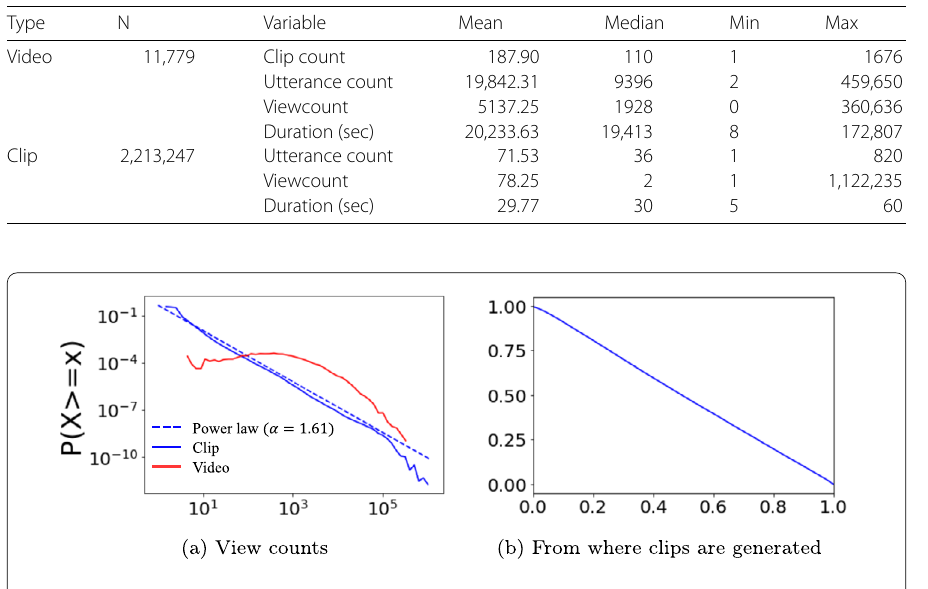
Table 1 Descriptive statistics of the collected